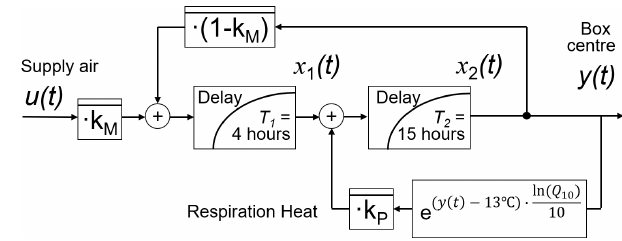
Figure 5. Parameter identification in phase 2 by the Cool-Ident model. For details see Jedermann et al. (2013).